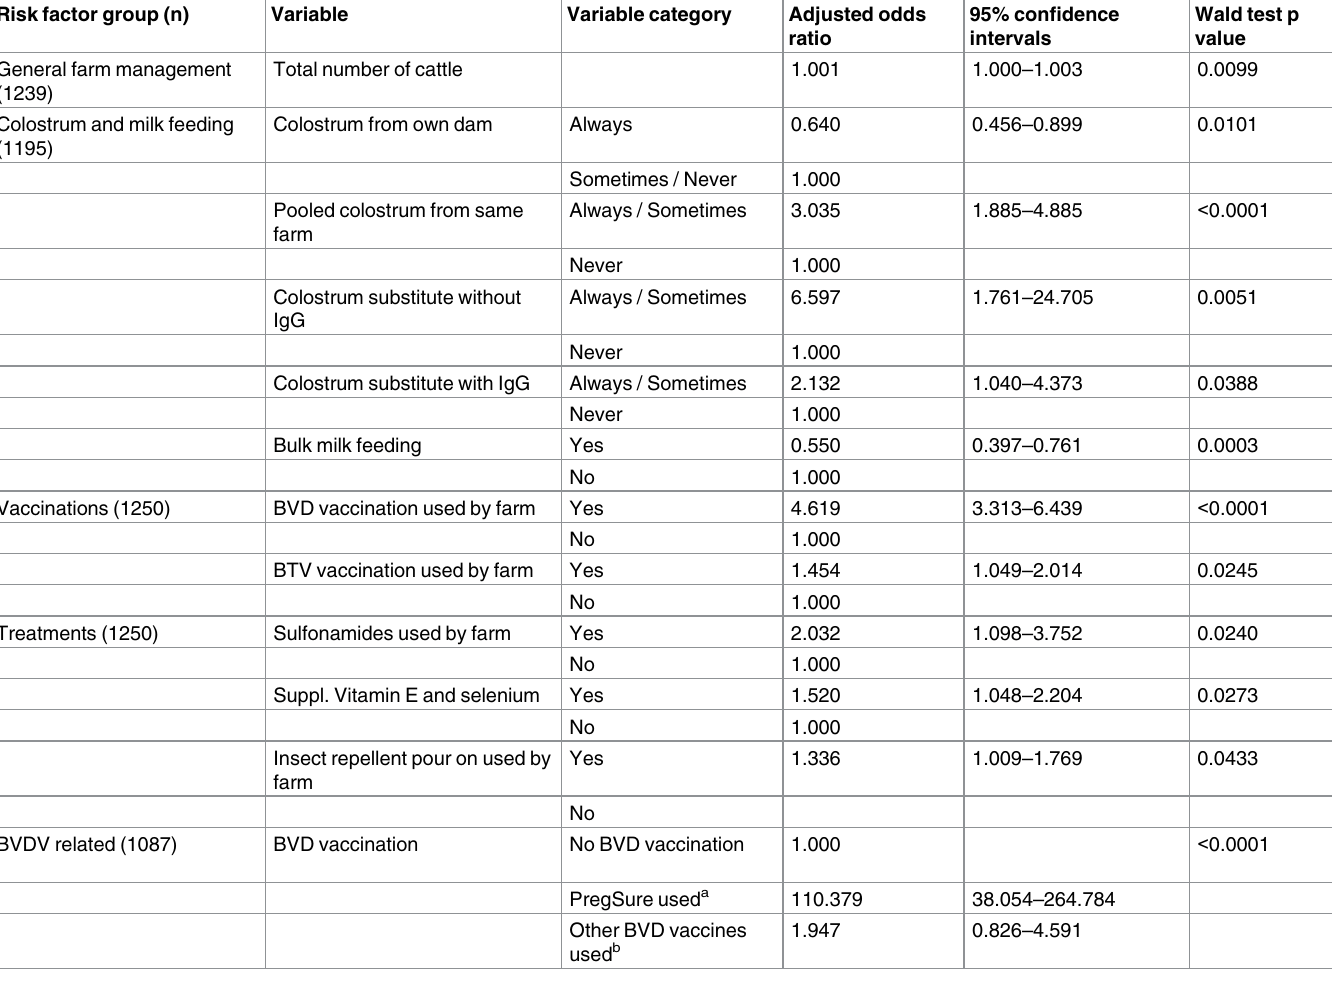
Table 4. Results of multivariable conditional logistic regression analysis for each of five risk factor groups for a multi-country BNP case-control study. Risk factor group